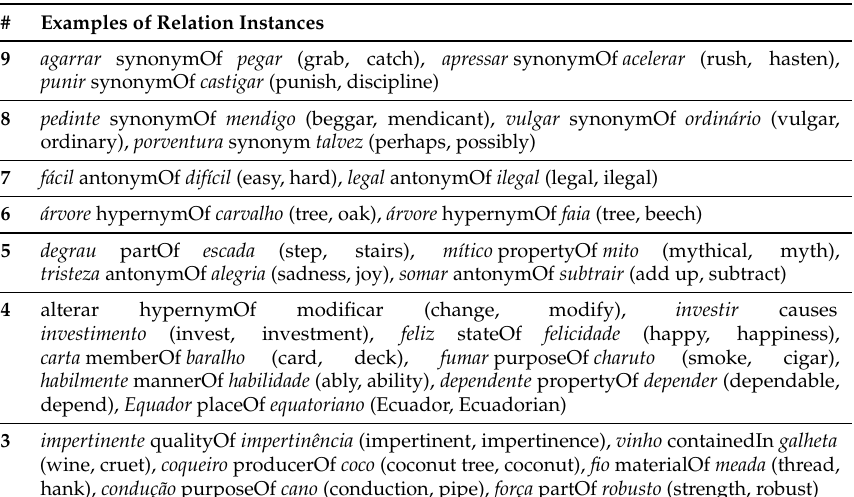
Table 6. Examples of redundant relation